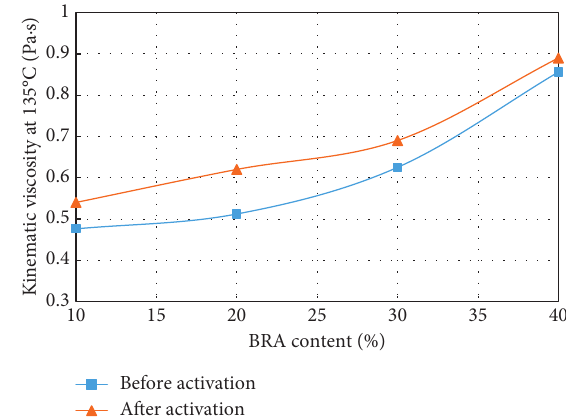
Figure 5: Chart of kinematic viscosity at 135 ° C of BRA-modified asphalt with dosage before and after activation.